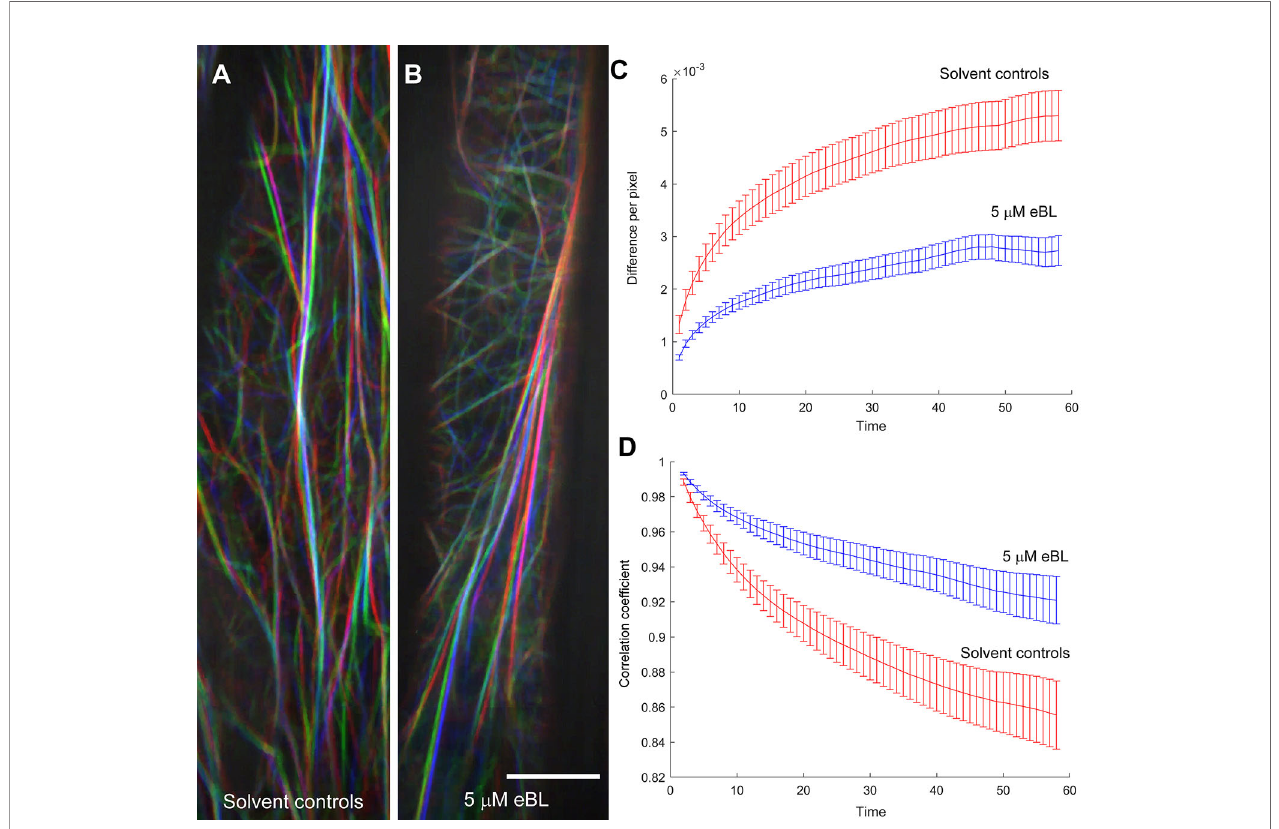
FIGURE 6 | Epi-Brassinolide (eBL) inhibited global F-actin dynamics in etiolated hypocotyl epidermal cells of M. truncatula expressing UBQ10:Lifeact-mGFP . Representative images of three time points (20, 40 and 60 s) of solvent controls (A) and eBL treated (B) cells as separate color channels in red, green and blue (RGB) image. White overlay in each image indicates low dynamics. Scale bar = 10 m m. Time-lapse movies corresponding to the merged images are presented as Supplemental Movie S1 (for untreated) and S2 (eBL-treated). Quanti fi cation of global F-actin dynamics based on changes in pixel (C) and decay of the correlation coef fi cient (D) . Statistical analyses of correlation coef fi cients and total difference in hypocotyl epidermal cells as a function of temporal intervals. Correlation/difference for solvent controls versus eBL-treated hypocotyls are as follows: 0.02086*/0.007597* (20 s); 0.03*/0.006639* (40 s) and 0.057/0.006069* (60 s). Adjusted P-values are shown for rejecting equivalence of means; values marked by an asterisk indicate statistical signi fi cance at the 0.05